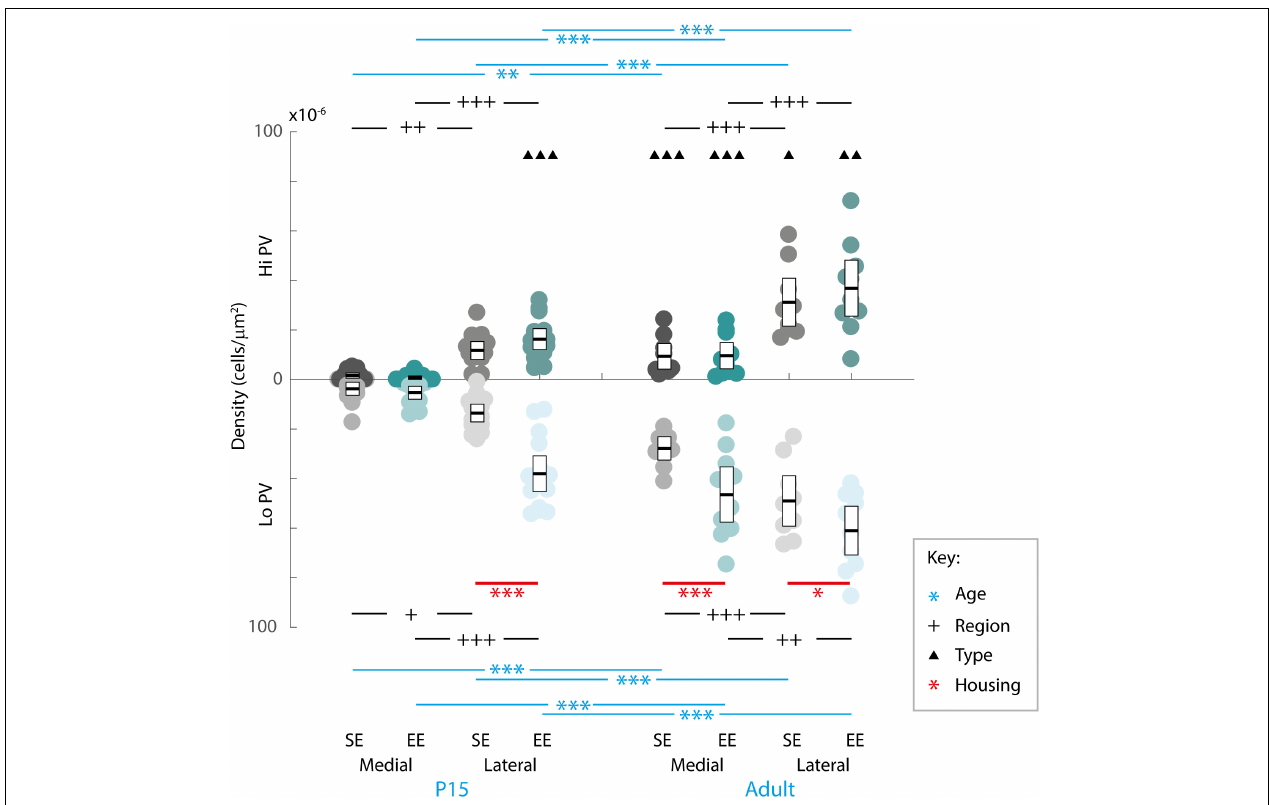
FIGURE 2 | Age, region, cell type as well as housing conditions influence striatal PV expression. Striatal PV cell density (counts per micrometer 2 ) in standard (SE) and enriched (EE) mice at all age points assessed. Blue bars and asterisks (Age): Both Hi PV (above abscissa) and Lo PV (below abscissa) cell densities were significantly greater in adult compared to P15 samples in SE medial (Hi PV: p = 0.001; Lo PV: p < 0.001), lateral (Hi PV: p < 0.001; Lo PV: p < 0.001), as well as EE medial (Hi PV: p < 0.001; Lo PV: p < 0.001) and lateral (Hi PV: p < 0.001; Lo PV: p < 0.001) striatum. Black bars and crosses (Regions): PV positive cell density in the lateral region was significantly higher compared to medial striatum for Hi and Lo PV cells in P15 SE (Hi PV: p = 0.001; Lo PV: p = 0.011), EE (Hi PV: p < 0.001; Lo PV: p < 0.001), as well as adult SE (Hi PV: p < 0.001; Lo PV: p < 0.001) and EE (Hi PV: p < 0.001; Lo PV: p = 0.002) samples. Black triangles (Hi versus Lo PV): While no differences between PV cell types were revealed for either region at P15 for SE mice ( p > 0.398, all comparisons), significantly greater Lo PV compared to Hi PV densities were observed in lateral striatum for EE cohorts ( p < 0.001). By adulthood, Lo PV densities were significantly higher in both medial and lateral portions of the nucleus for SE (SE medial: p < 0.001; lateral: p = 0.014) as well as EE samples (EE medial: p < 0.001; lateral: p = 0.001). Red bars and asterisks (Housing): At P15, significantly greater Lo PV densities were detected in EE relative to SE samples in lateral striatum ( p < 0.001). Lo PV cells continued to exhibit significantly higher densities in both medial ( p < 0.001) and lateral ( p = 0.049) regions of adult EE sections. No differences in Hi PV densities were observed. Means (solid bar) and standard errors of the mean (s.e.m.; extent of white boxes) are depicted. Individual values are depicted as coloured circles: darker greys: medial SE;